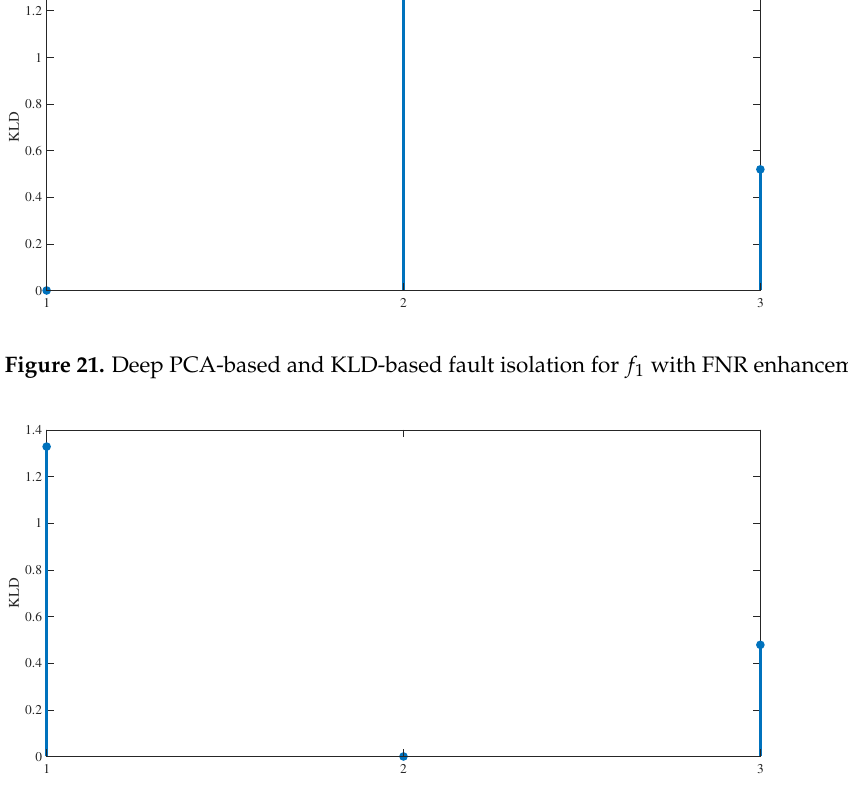
Figure 22. Deep PCA-based and KLD-based fault isolation for f 2 with FNR enhancement.